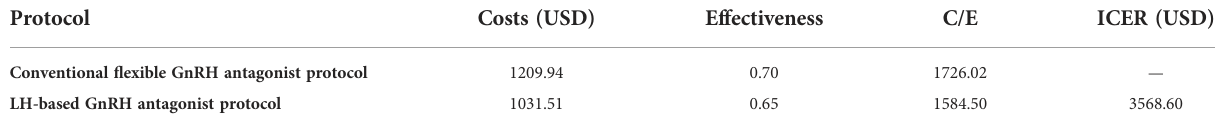
TABLE 5 Cost-effectiveness analysis of the LH-based and conventional fl exible GnRH antagonist